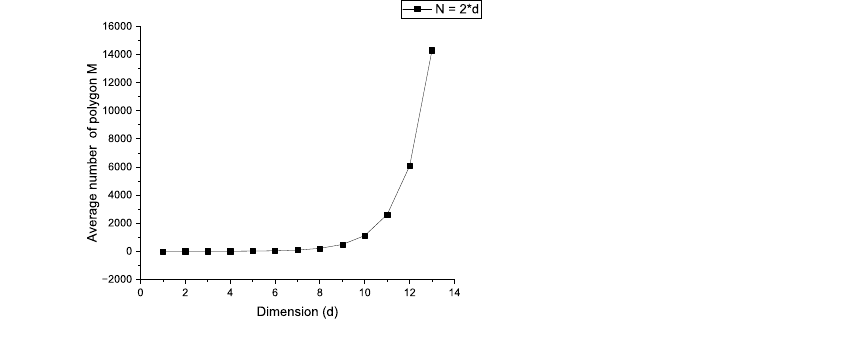
Figure 7. Relationship between the number of initial points N and the number of polygons M when the initial number of polygons is N = 2 ∗ d